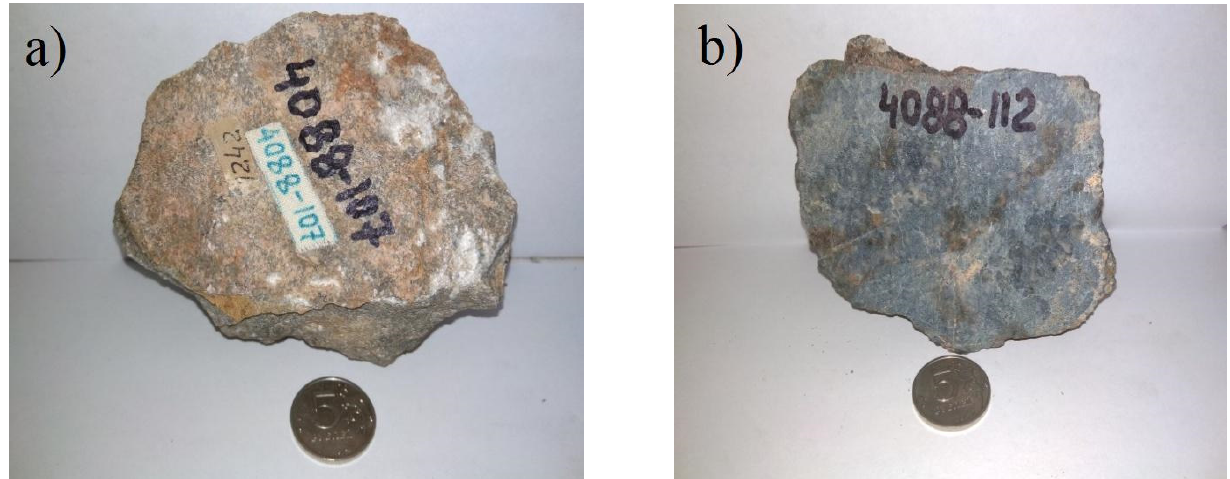
Figure 3. Photographs of rock samples 4088-107 from the Chapaevskoe deposit ( a ) and 4088-112 pegmatite vein from the Yaroslavskoe deposit ( b ). Coin diameter is 2.5 cm.